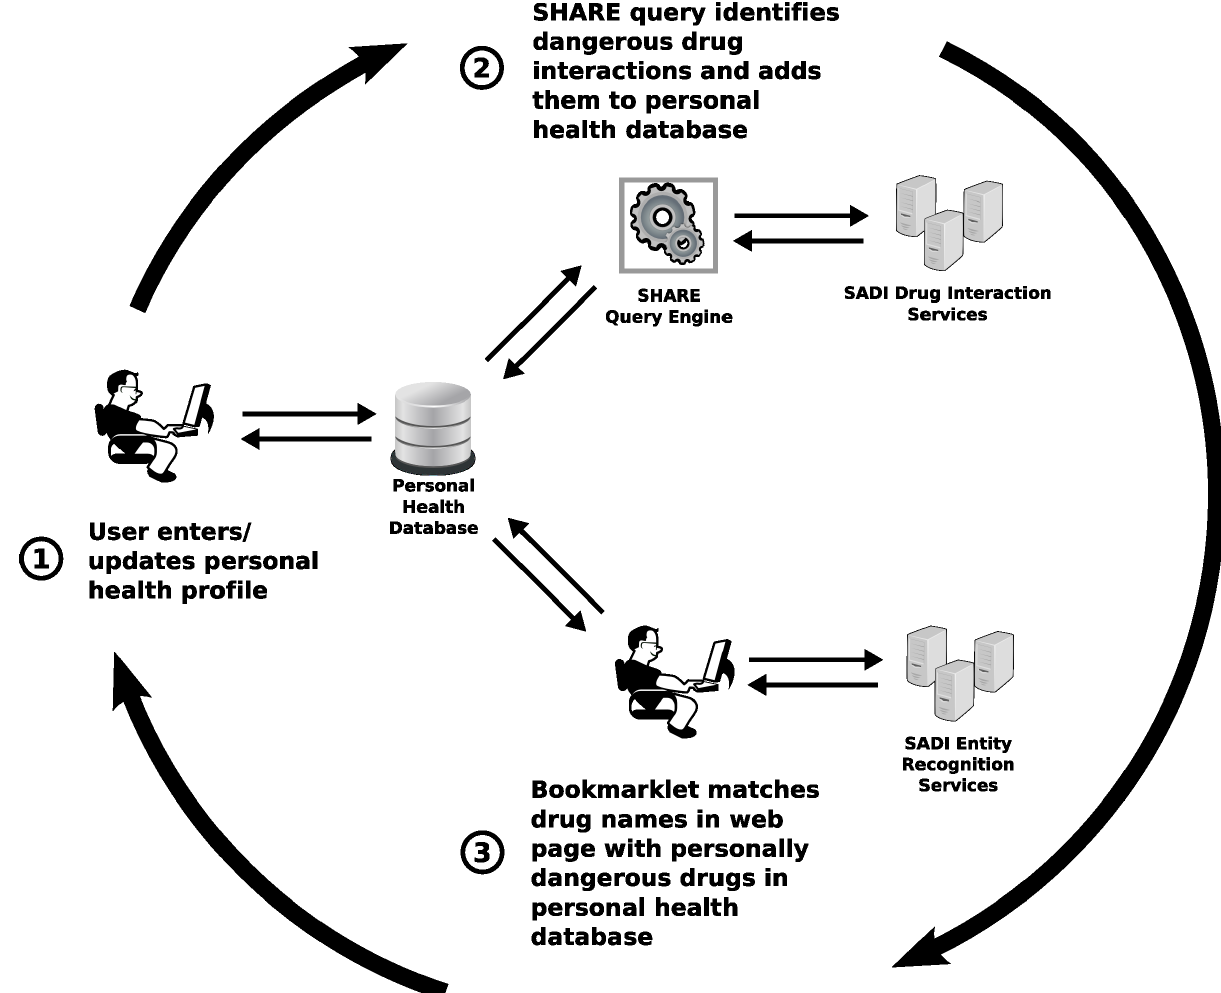
Figure 1. An overview of the SADI Personal Health Lens system. In Step 1, the user enters or updates his/her personal health profile, which contains information such as sex, age, and current prescriptions. In Step 2, a SHARE query is used to aggregate interactions of any known drug with the user’s personal health profile. This query may be time-intensive and is performed as a separate step prior to interactive use of the system. In Step 3, the user browses the Web and clicks the Health Lens bookmarklet when reading a health-related webpage. The bookmarklet identifies drugs mentioned within the webpage using one or more SADI services for entity recognition, and compares those drugs with drugs in the personal health database that are known to be personally dangerous. Finally, the bookmarklet annotates the webpage with appropriate